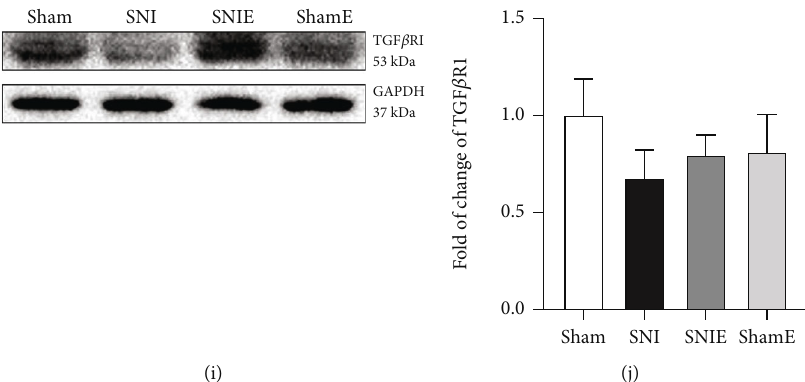
Figure 3: Exercise activates latent TGF- β 1 in the spinal cord tissue of four groups of mice 24 days after SNI surgery. (a) Representative images of western blot for TGF- β 1 monomer, TGF- β 1 dimer, and LAP-TGF- β 1. Western blotting analysis for the expression changes of (b) LAP-TGF- β 1, (c) dimer TGF- β 1 (25 kDa), and (d) monomer TGF- β 1 (12 kDa) ( n = 6 ). The ratio of (e) LAP-TGF- β 1/dimer TGF- β 1, (f) LAP-TGF- β 1/monomer TGF- β 1, and (g) LAP-TGF- β 1/monomer+dimer TGF- β 1 ( n = 6 ). (h) Total TGF- β 1: monomer+dimer+LAP- TGF- β 1/GAPDH ( n = 6 ). (i) Representative images of western blot for TGF β RI ( n = 6 ). (j) Western blotting analysis for the expression changes of TGF β RI ( n = 6 ). Values represent the mean ± SEM . ∗ P < 0 : 05 , ∗∗ P < 0 : 01 versus the sham group; # P < 0 : 05 , ## P < 0 : 01 versus the SNI group; and $ P < 0 : 05 versus the SNIE group.